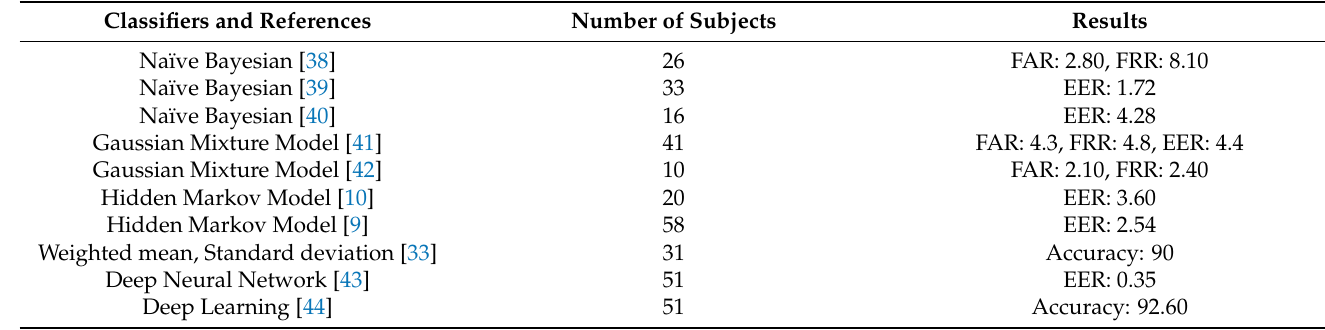
Table 2. Classification based on popular generative